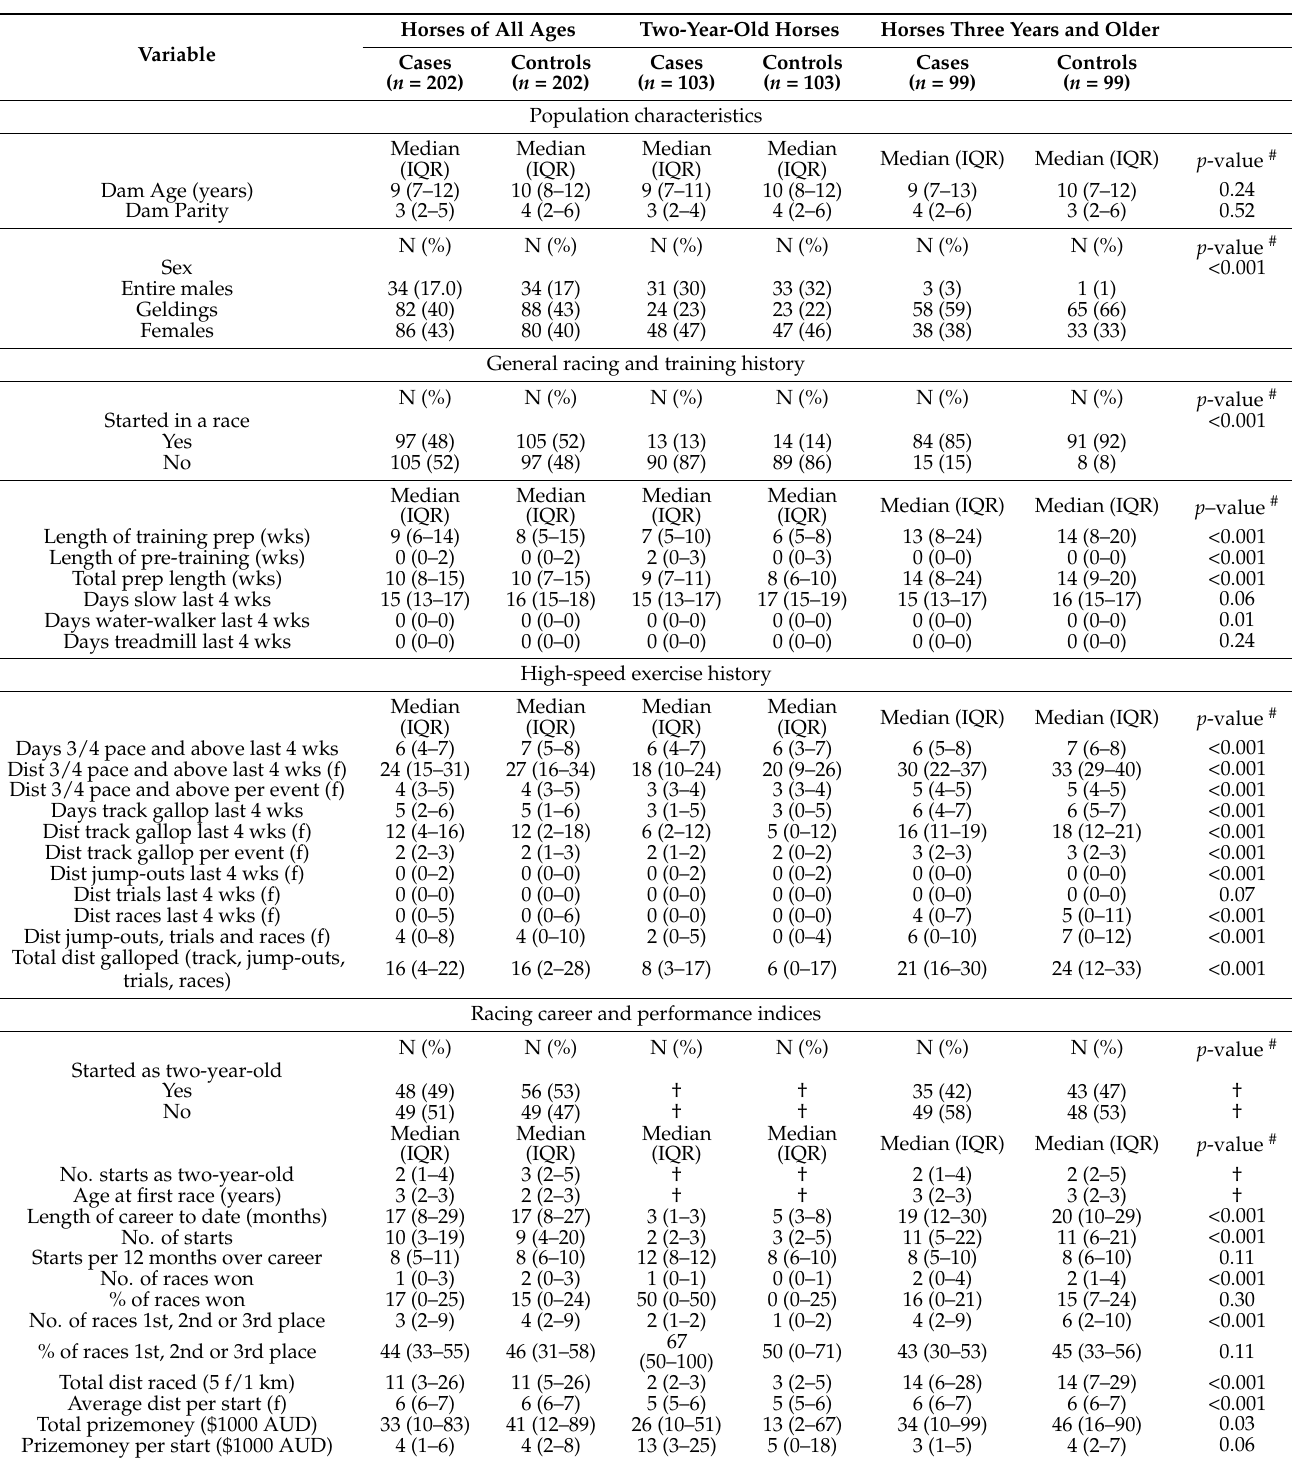
Table 1. The population characteristics, training characteristics, training and racing high speed exercise history, and racing career and performance indices for 202 cases of musculoskeletal injury and their controls (matched by trainer and age), stratified by